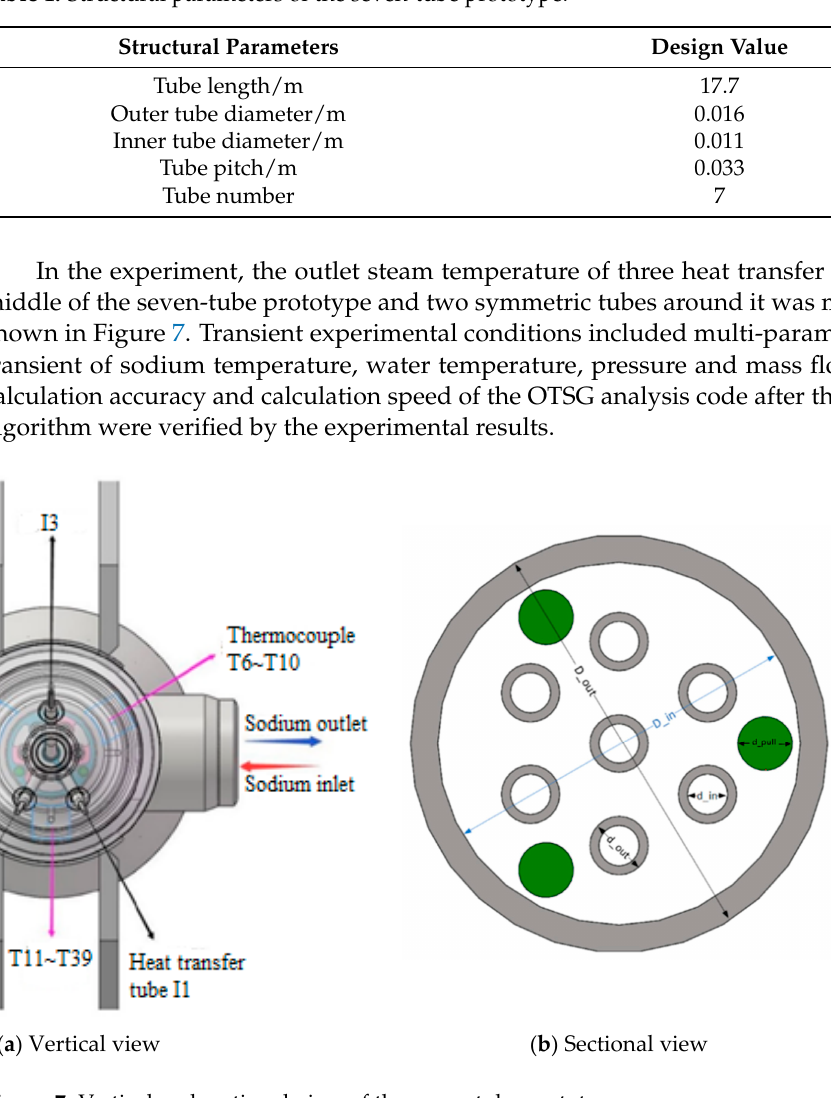
Table 1. Structural parameters of the seven-tube prototype.